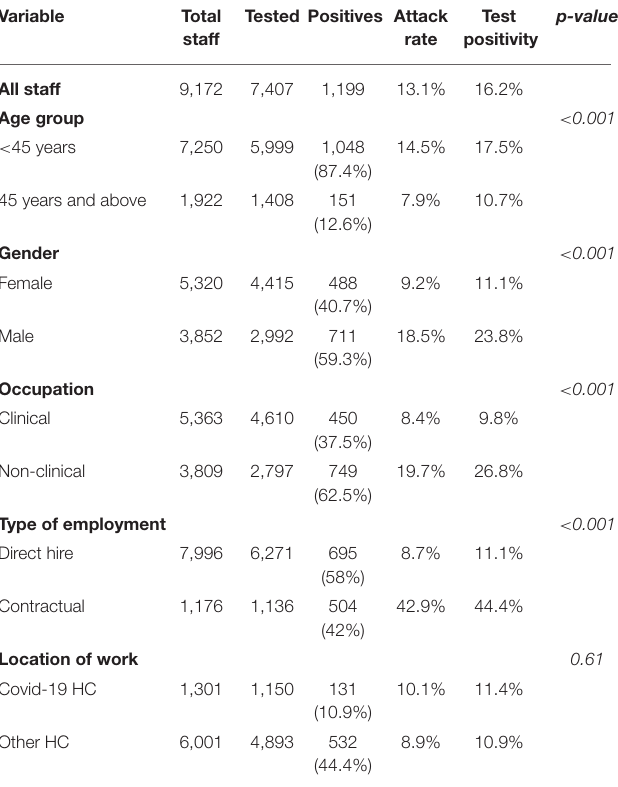
TABLE 1 | PHCC Staff Characteristics, screening proportion, attack rate and positivity rate (1 March − 31 October).